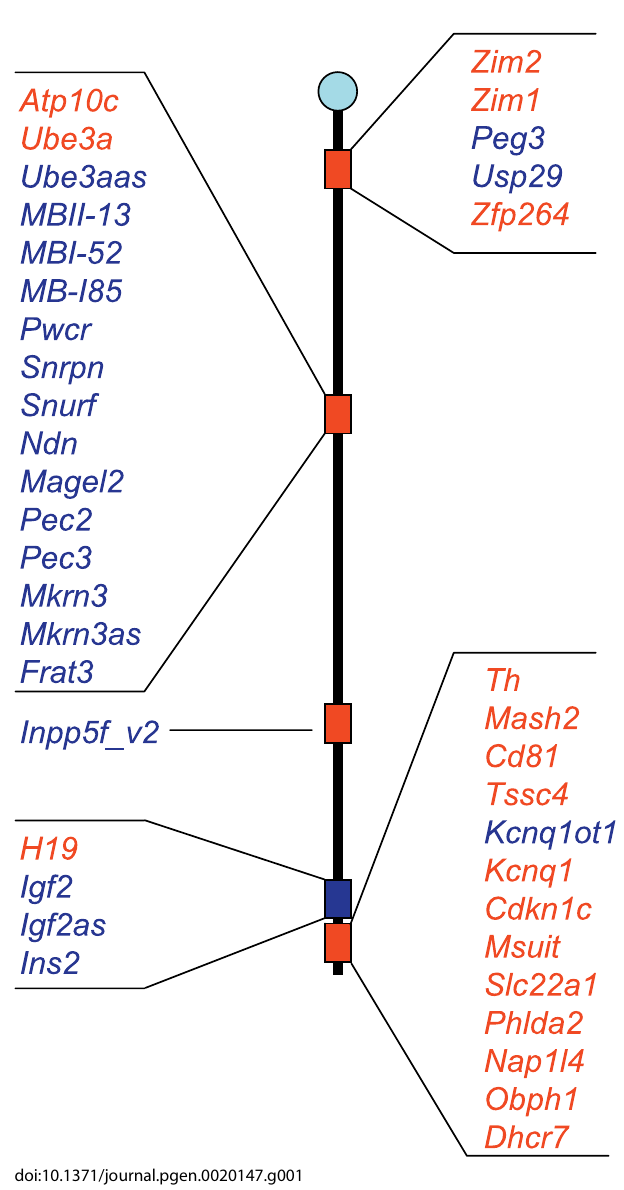
Figure 1. Imprinting on Mouse Chromosome 7 Maternally expressed genes are shown in red, paternally expressed in blue. Individual clusters are controlled by oocyte-derived (red) or sperm- derived (blue) methylation